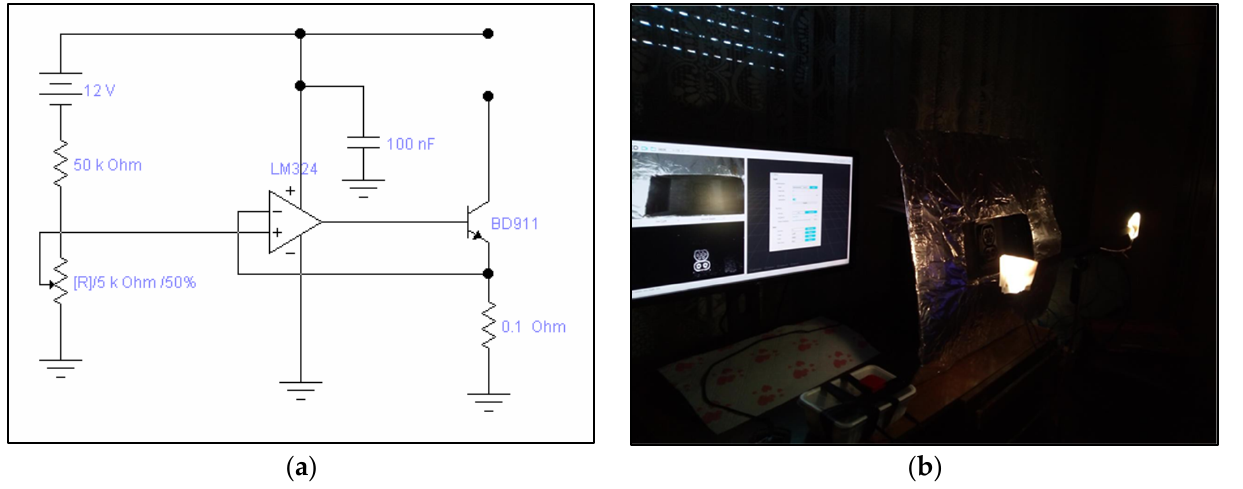
Figure 11. ( a ) LED lights regulation circuit and ( b ) experiment setup.